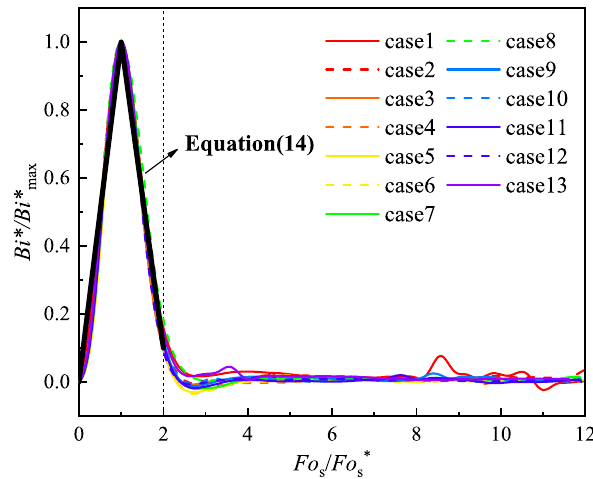
Figure 8. Non-dimensional surface heat flux versus dimensionless time.